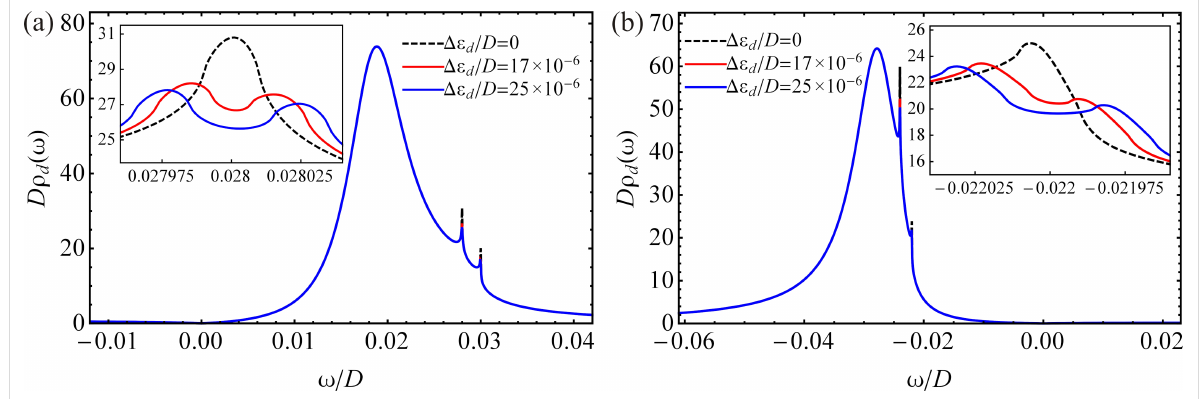
Figure 4: The nonequilibrium DOS in the QD for different values of the Zeeman energy with U / D → ∞ at temperature T / D = 5 × 10 − 6 and for different parameters: (a) μ L / D = 0.028, μ R / D = 0.030, η = 0.02 and ε d / D = − 0.011. (b) μ L / D = − 0.024, μ R / D = − 0.022, η = 0.015 and ε d / D = − 0.068.